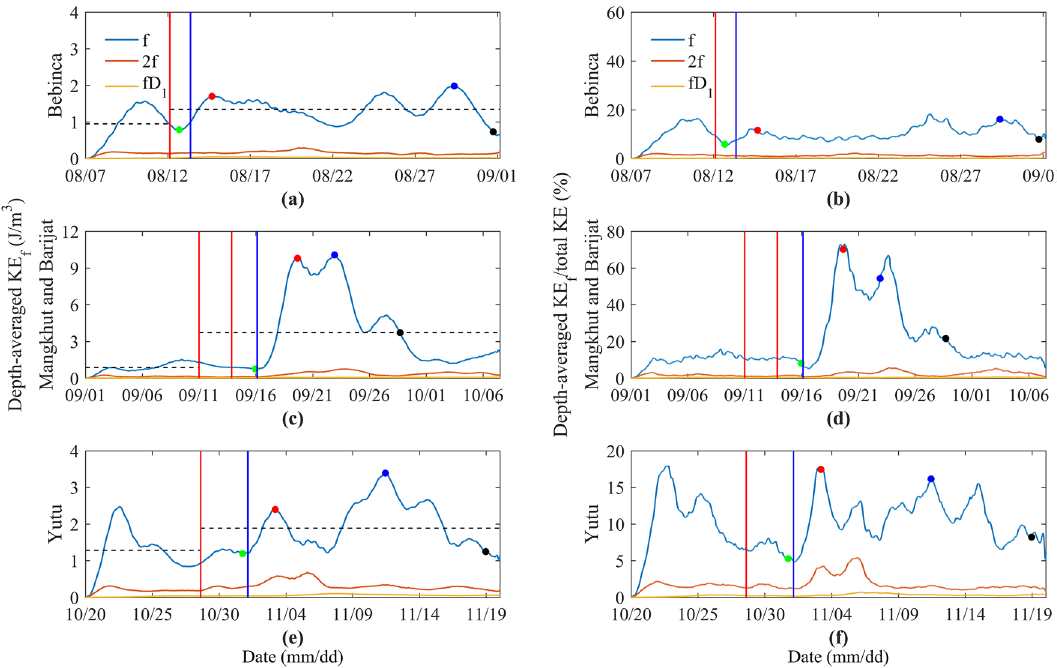
Figure 5. The temporal variations of the depth-averaged NIKE, 2f and fD 1 energy of band and percentage of total KE during the passage of typhoons Bebinca ( a,b ), Barijat and Mangkhut ( c,d ), and Yutu ( e,f ), respectively. The green dots are the moments when the NIKE started to increase, the red dots are NIKE peaks in the forcing stage, the blue dots are NIKE peaks in the relaxation stage, and the black dots represent the e-folding time of depth-averaged NIKE. The red vertical lines are same as Fig. 1. The blue vertical lines are time of the max wind speed.